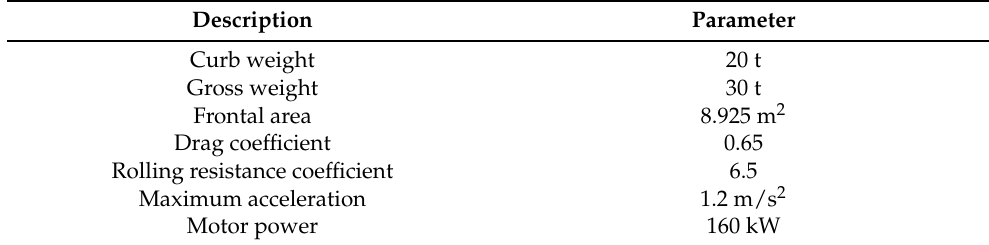
Table 5. Conventional trolleybus specifications.